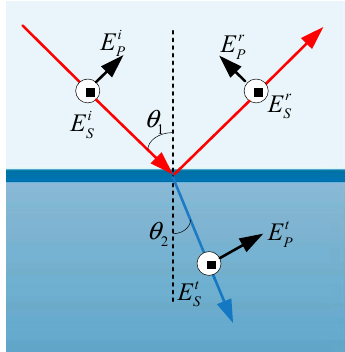
Figure 1. E-vector of an incident beam is reflected and refracted by the interface, E r is the reflected component, E t is the refracted component, and E s and E p are vertical and parallel component, respectively.